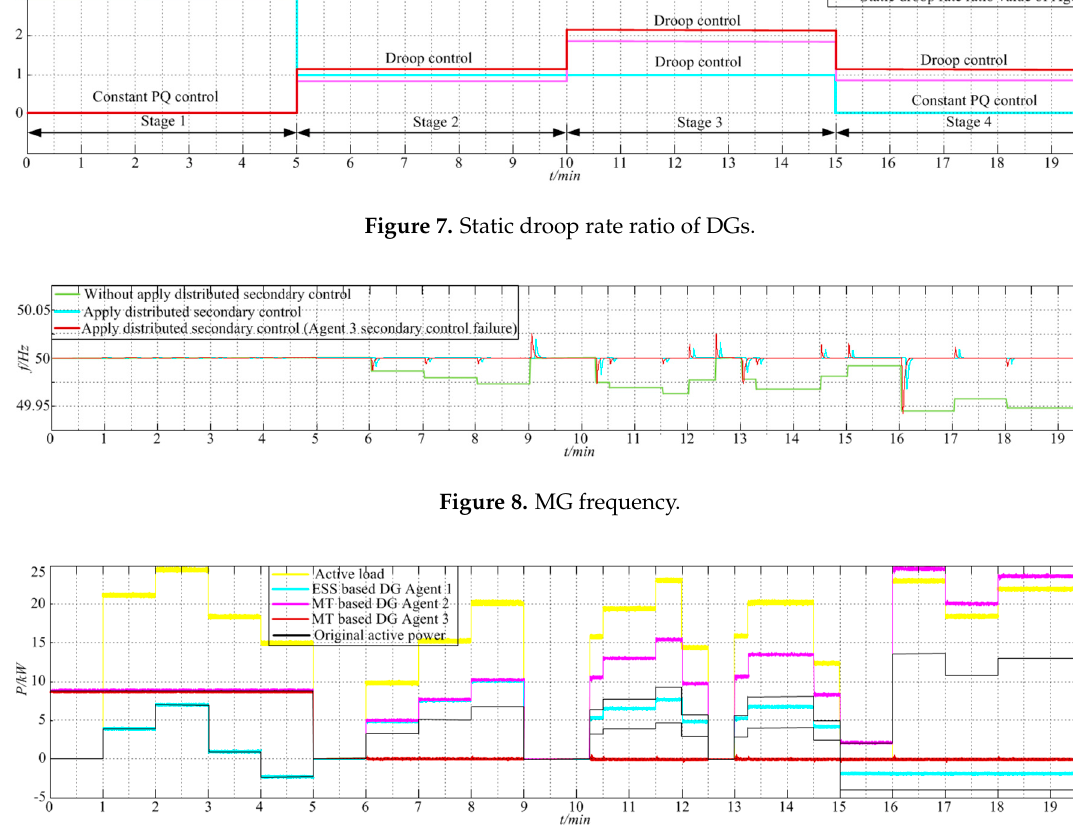
Figure 9. Active power outputs of DGs when secondary control of DG 3